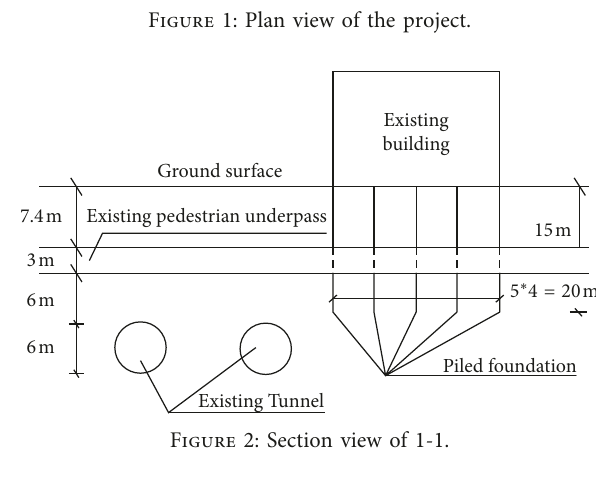
Figure 1: Plan view of the project.